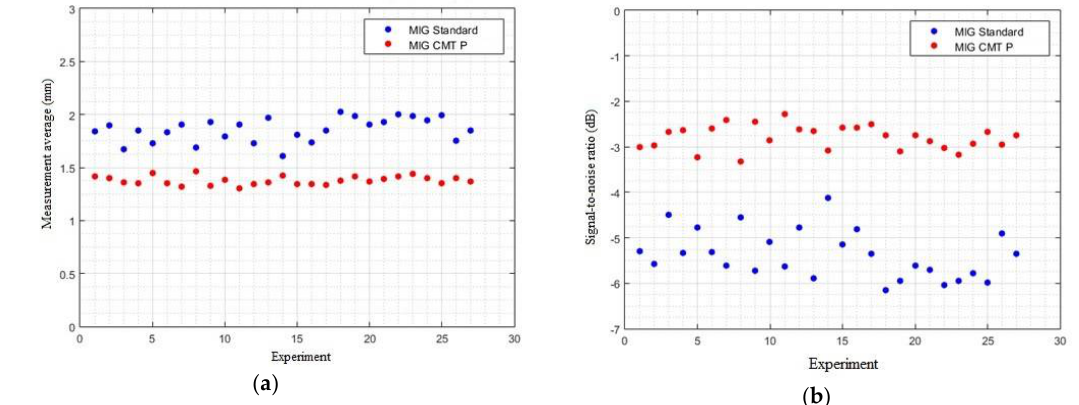
Figure 5. Bead width evaluation: ( a ) measurement (mm); ( b ) signal-to-noise ratio (dB).